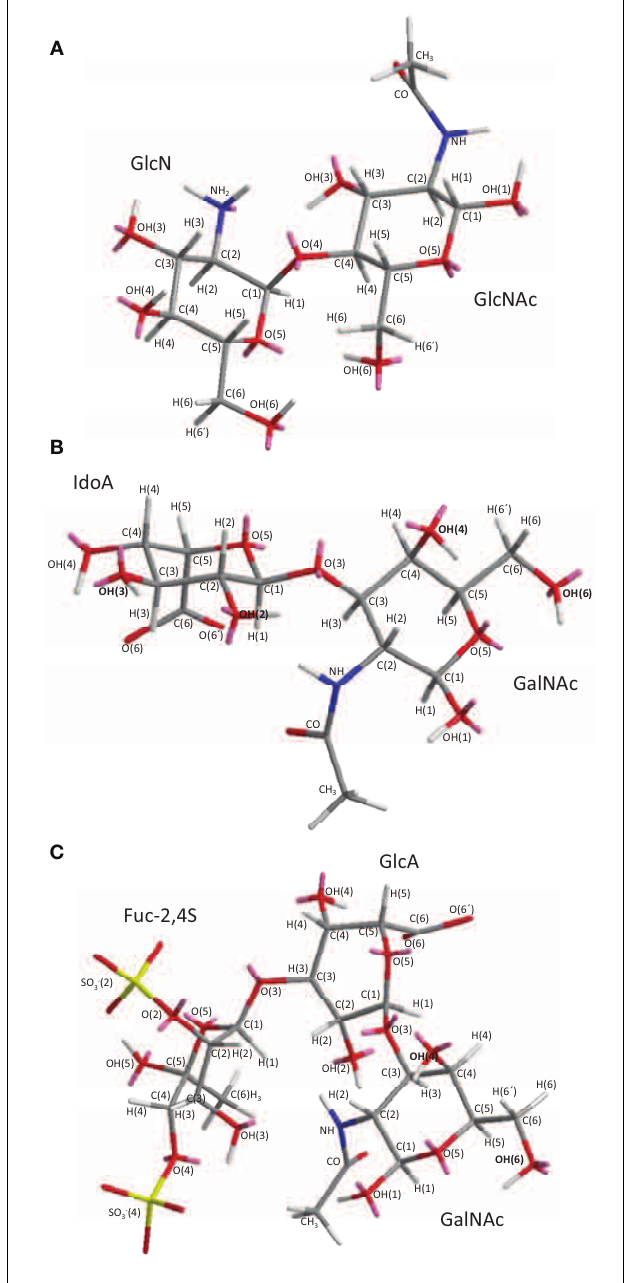
FIGURE 1 | 3D structural representation of the marine glycans (A) chitin and chitosan, (B) ascidian dermatan sulfates (DSs), and (C) sea-cucumber fucosylated chondroitin sulfate (FucCS). These pictures represent the lowest-energy conformations obtained by computational simulation on Chem3D Ultra 8.0 software using 10,000 step intervals of 2.0 fentosecond each, at 298K and heating/cooling rate of 1000Kcal/atom/ps. (A) Chitin and chitosan are composed of β -(1–4)-linked D-glucosamine (GlcN) and N -acetyl D-glucosamine (GlcNAc) units with different amounts. Chitin has ≥ 70% GlcNAc units while chitosan is composed of ≤ 30% of this same unit. (B) The DS from ascidian Styela plicata, Halocynthia pyriformis , and Phallusia nigra are composed of [ → 4)- α -L-IdoA-(2R 1 ,3R 2 )-(1 → 3)- β -D-GalNAc-(4R 3 , 6R 4 )-(1 → ] n with